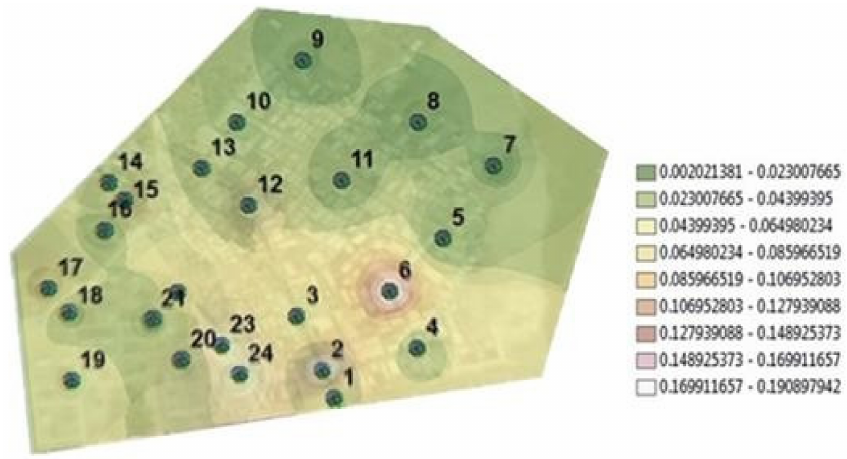
Figure 7. PM 10 maximum concentration ( µ g/m 3 ) distribution throughout the